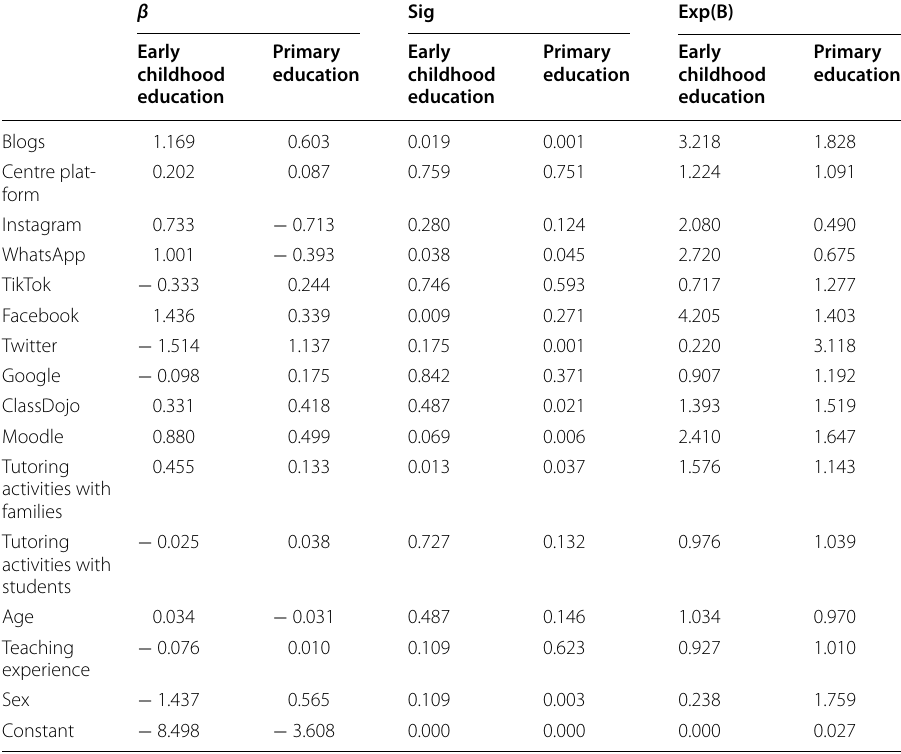
Significance level at